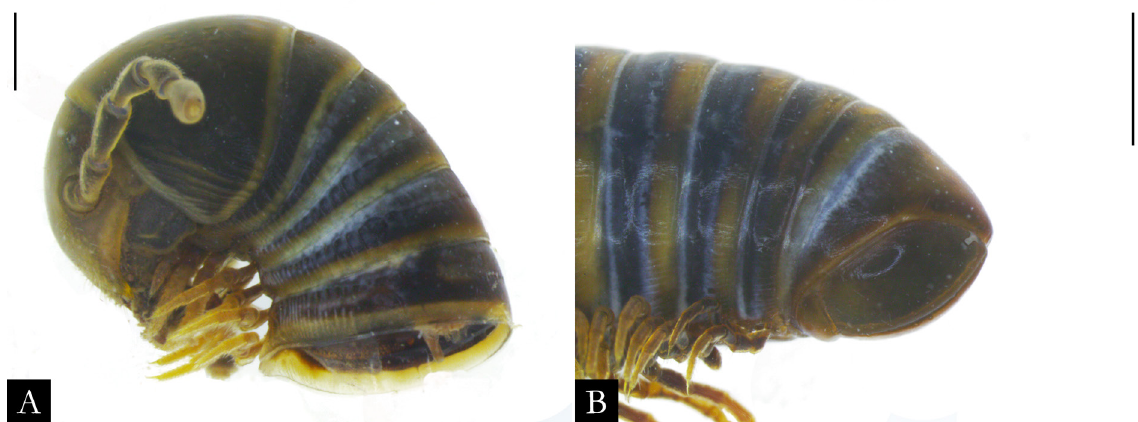
Fig. 98. Pseudonannolene occidentalis Schubart, 1958, ♂ (IBSP 1998), in lateral view. A . Anterior region. B . Posterior region. Scale bars = 1